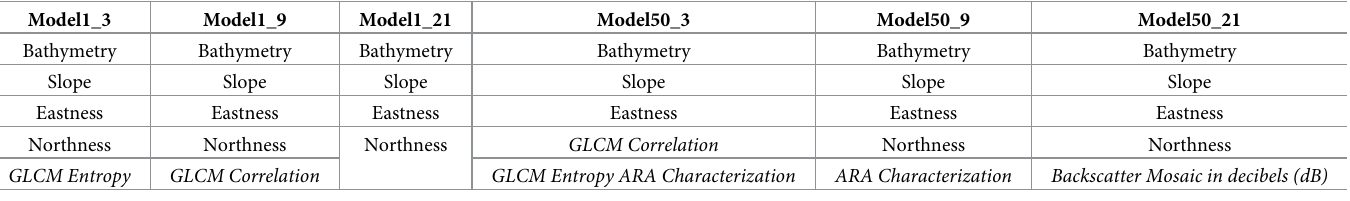
Table 2. Low correlation between predictors for each model, Model1_3, Model1_9, Model1_21, Model50_3, Model50_9, and Model50_21extracted using Pearson Product-moment correlation